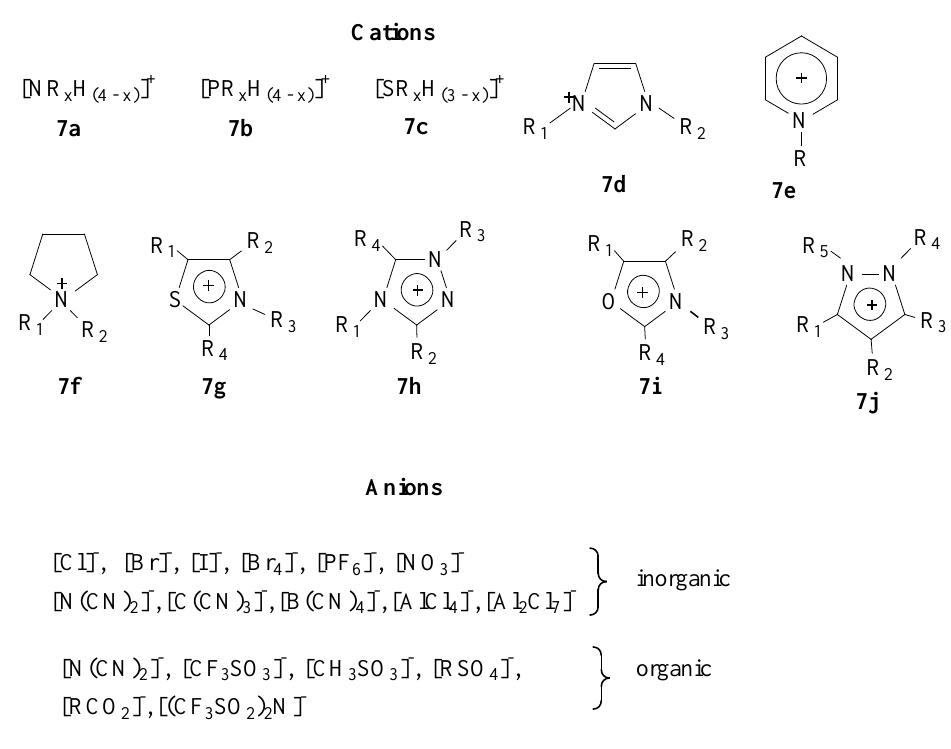
Figure 4. Examples of cations and anions described in ionic liquids.